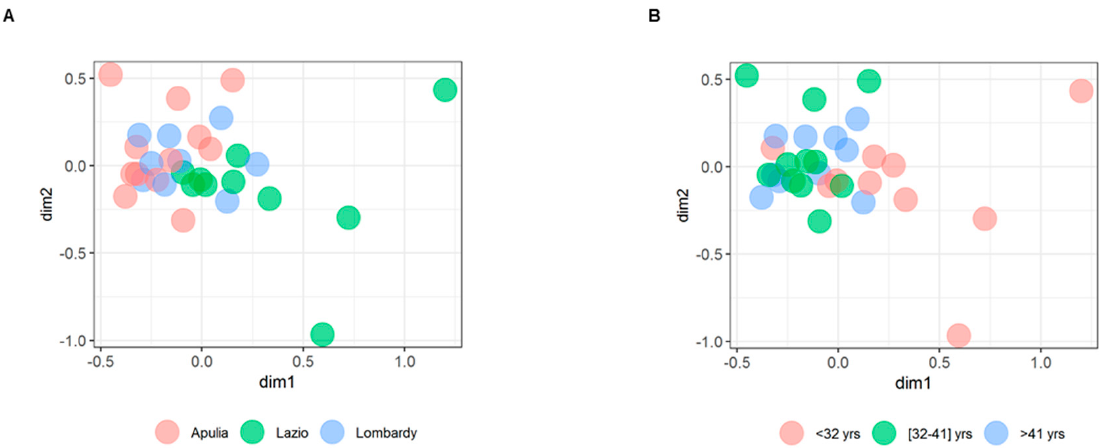
Figure 5. Kruskal’s non-metric MultiDimensional Scaling (MDS) plots of the Bray-Curtis dissimilarities in Italian healthy subjects grouped by regions of origin ( A ) and age classes ( B ). Each point plotted into the bi-dimensional space (as X, Y coordinates) represents an individual. Individuals that are more similar to one another are ordinated closer together and those who belong to di ff erent groups were marked by di ff erent colors. Mean silhouette value was 0.0069 for clustering by regions and − 0.0225 for clustering by age classes.